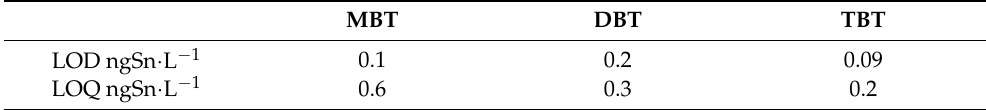
Table 2. Detection and quantification limits of the organotin analysis